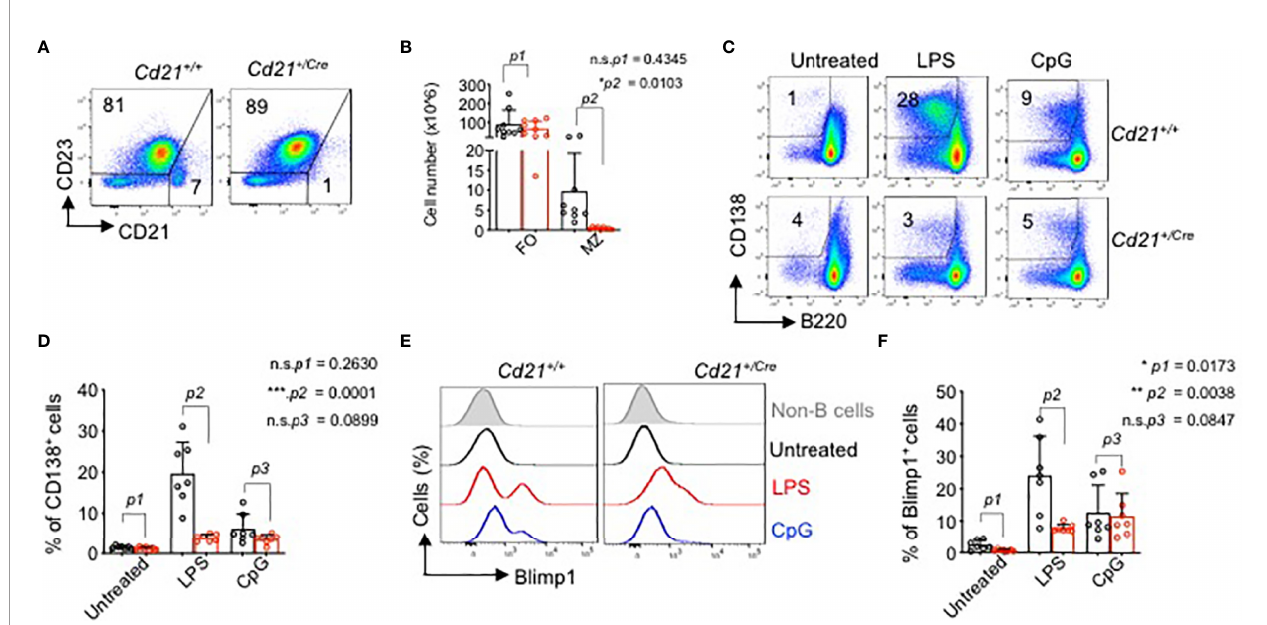
FIGURE 7 | Impaired marginal zone B cell development and plasma cell differentiation in RhoA fl / fl Cd21 +/Cre mice. ( A ) Flow cytometric analysis of splenic cells from RhoA fl / fl and RhoA fl / fl Cd21 +/hCre mice for surface expression of the indicated markers. Data are representative of 9 mice. (B) Absolute cell numbers of MZ (CD21 hi CD23 - ) and FO (CD21 low CD23 + ) cells. Statistical analysis- two tailed unpaired student t test. (C) Flow cytometric analysis of plasma cell differentiation (CD138 + ) of splenic cells from RhoA fl / fl and RhoA fl / fl Cd21 +/Cre mice upon stimulation with 2.5 µg/ml LPS or 2.5 µM CpG after 4 days of treatment. Cells were pre- gated on CD19 + cells. (D) Quanti fi cation of CD138 + B cells in LPS-, CpG- and non-treated splenocytes at day 4 post stimulation. N=7 independent mice per group, and error bars represent mean ± SD. Unpaired t-test, two-tailed. (E) Histogram showing the expression of BLIMP-1 in B cells from RhoA fl / fl and RhoA fl / fl Cd21 +/Cre mice upon stimulation with LPS and CpG as detected by Intracellular fl ow cytometry. (F) Quanti fi cation of BLIMP-1 + splenic B cells (pre-gated on CD19 + cells). N=7 independent mice per group, and error bars represent mean ± SD. Unpaired t-test, two-tailed. *p<0.05, **p<0.01, ***p< 0,001, ns, not signi fi